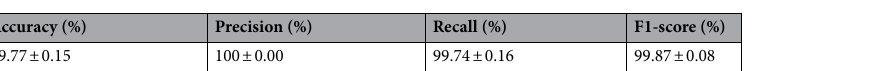
Table 4. Classification results for the ResNet18 architecture (normal vs. cancer). Values are mean ± standard deviation for five experimental